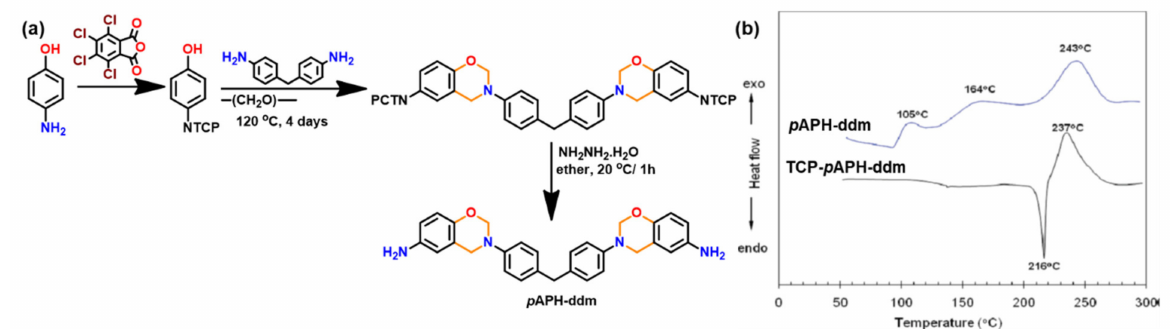
Figure 49. ( a ) Preparation of amino-functional benzoxazine monomers using TCP-protected p APH, ( b ) DSC thermograms of TCP-protected and unprotected Bz monomers [322]. Copyright 2010. Reproduced with permission from American Chemical Society.